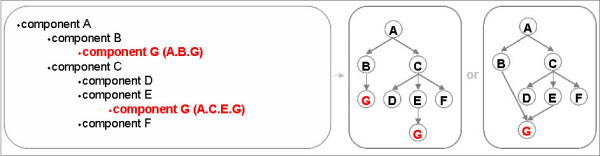
Employing visualisation for the representation of complex relationships within data. The collapsible text index contains a component G with multiple parentage; it is necessary to provide two separate text entries to show descent from each parent. The corresponding directed acyclic graph (DAG) could either represent the data with two separate nodes (clones) or display the node G only once, with a link to it from each parent. Advantages in the latter representation include a reduction in the amount of data displayed to users.